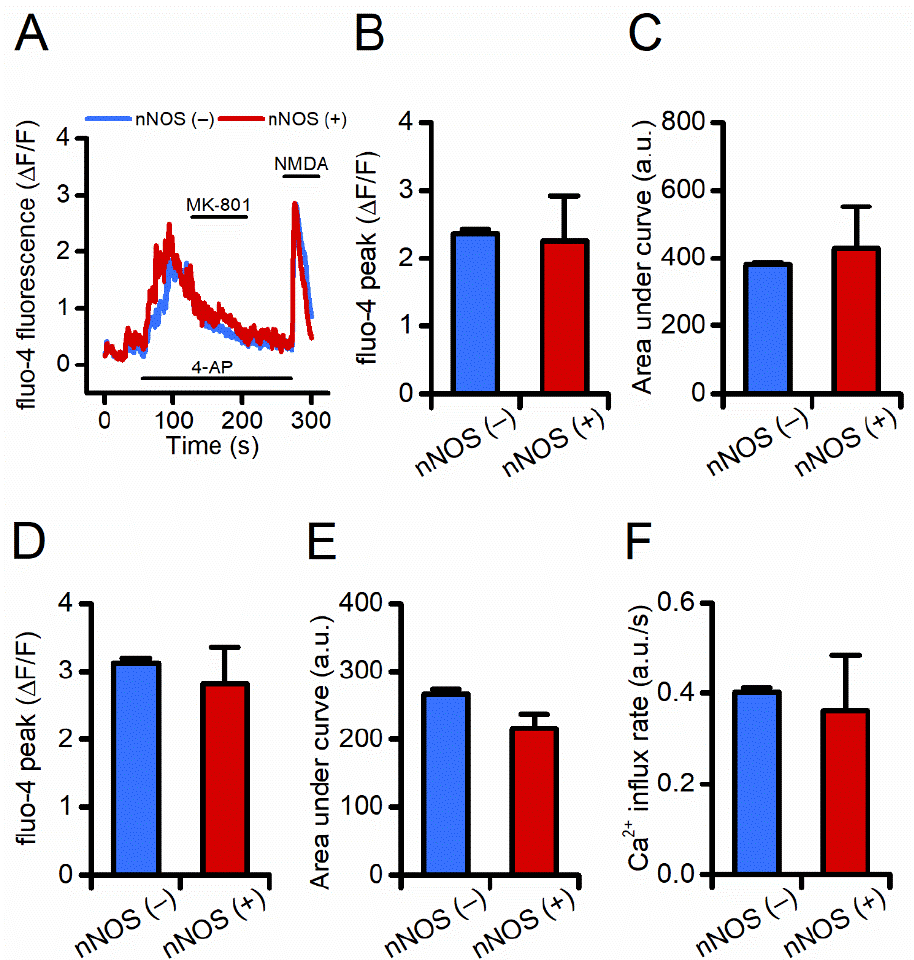
Figure 2. nNOS (+) and the general population of nNOS ( − ) neurons show overlapping intracellular Ca 2+ rises upon activation of synaptic and extrasynaptic NMDARs. ( A ) Representative time courses of fluo-4 loaded nNOS ( − ) and nNOS (+) striatal neurons exposed to a pharmacological maneuver set to activate synNMDARS and exNMDARs. ( B ) Bar graph depicts peak of [Ca 2+ ] i values obtained in the two populations during synNMDAR activation [fluo-4 peak in nNOS ( − ): 2.36 ± 0.05 vs. 2.25 ± 0.66 in nNOS (+) neurons, p = 0.81, n = 389 nNOS ( − ) vs. n = 5 nNOS (+) neurons from four independent experiments]. ( C ) Bar graph depicts cumulative [Ca 2+ ] i changes in the two populations expressed as area under the curve (AUC) of arbitrary units (a.u.) during synNMDAR activation [fluo-4 AUC in nNOS ( − ): 379.28 ± 8.84 vs. 429.01 ± 122.89 in nNOS (+) neurons, p = 0.53]. ( D ) Bar graph depicts peak of [Ca 2+ ] i values obtained in the two populations during exNMDAR activation [fluo-4 peak in nNOS ( − ): 3.12 ± 0.06 vs. 2.81 ± 0.53 in nNOS (+) neurons, p = 0.59]. ( E ) Bar graph depicts cumulative [Ca 2+ ] i changes in the two populations during exNMDAR activation [fluo-4 AUC in nNOS (-): 266.08 ± 7.33 vs. 216.22 ± 20.61 in nNOS (+) neurons, p = 0.07]. ( F ) Bar graph depicts Ca 2+ influx rate in the two populations expressed as a.u. changes per second during exNMDAR activation (influx rate in nNOS ( − ) 0.40 ± 0.009 vs. 0.36 ± 0.12 in nNOS (+) neurons, p = 0.63]. 3.3. Compared to nNOS ( − ) Neurons, nNOS (+) Neurons Show Reduced Transcriptomic and Protein Expression of the NMDAR Subunit 1 Previous studies investigating the expression of NMDAR subunits in nNOS (+) neu- rons have provided contrasting results [27,36–39]. To address this question in our system, we performed qRT-PCR on a set of selected transcripts obtained from pools of nNOS ( − ) and nNOS (+) neurons (11 to 18 neurons per sample, Figure 3A). Analysis of qRT-PCR data showed that, compared to nNOS ( − ), nNOS (+) neurons exhibit reduced expression of Grin1 , the gene encoding for the mandatory NMDAR subunit GluN1 (also known as